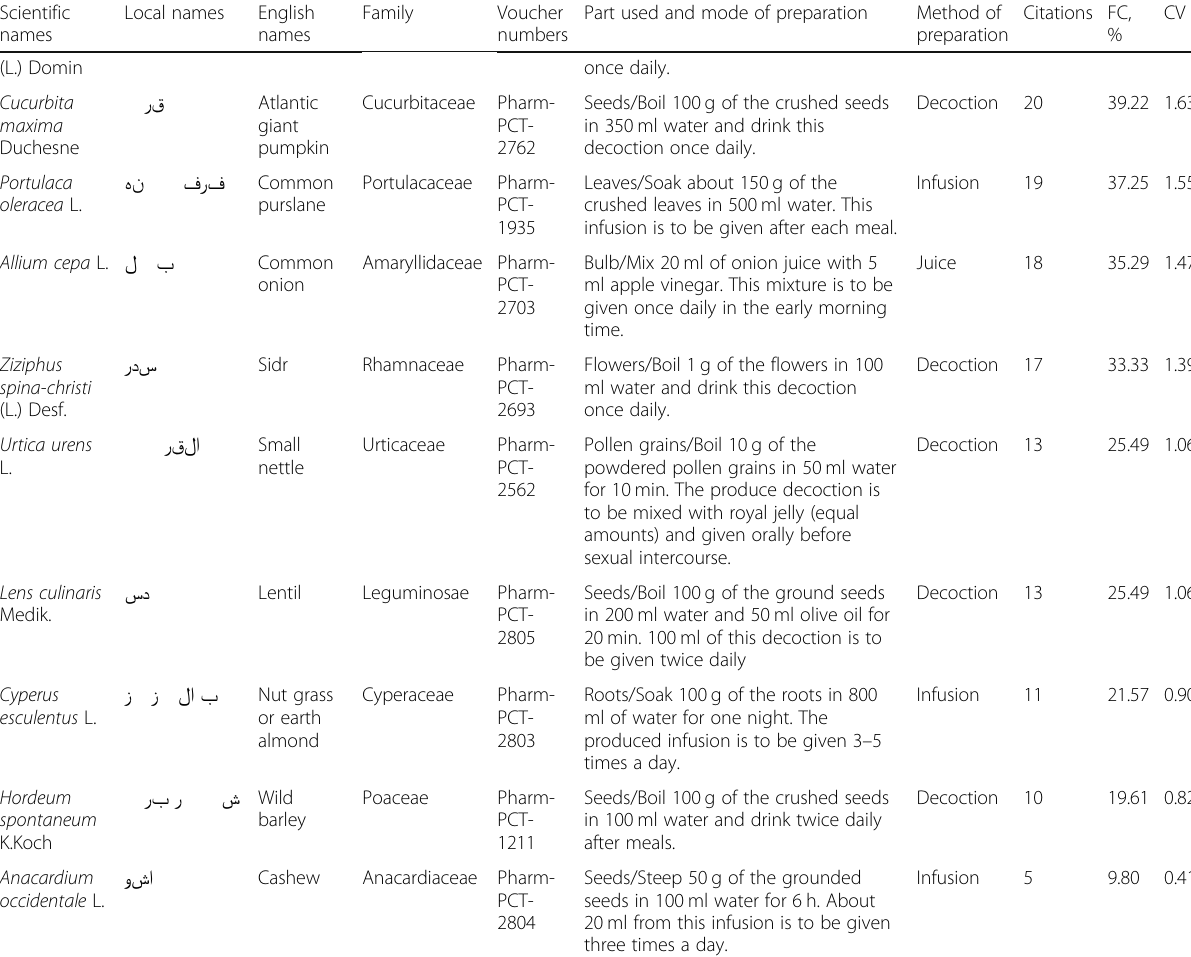
Table 3 The used herbals for the treatment of infertility in males, the plant ’ s parts used, Frequency of Citations (FC), Choice values, modes of administration and methods of preparation (Continued)